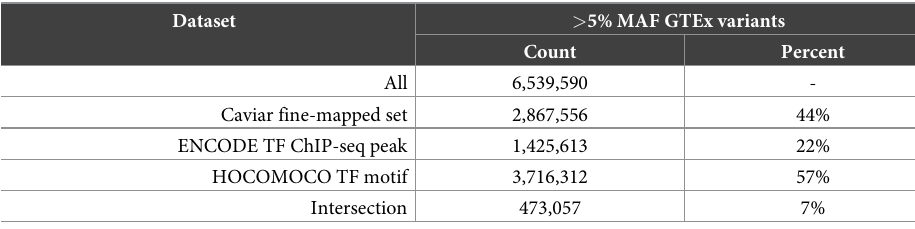
Table 1. GTEx variant annotations.